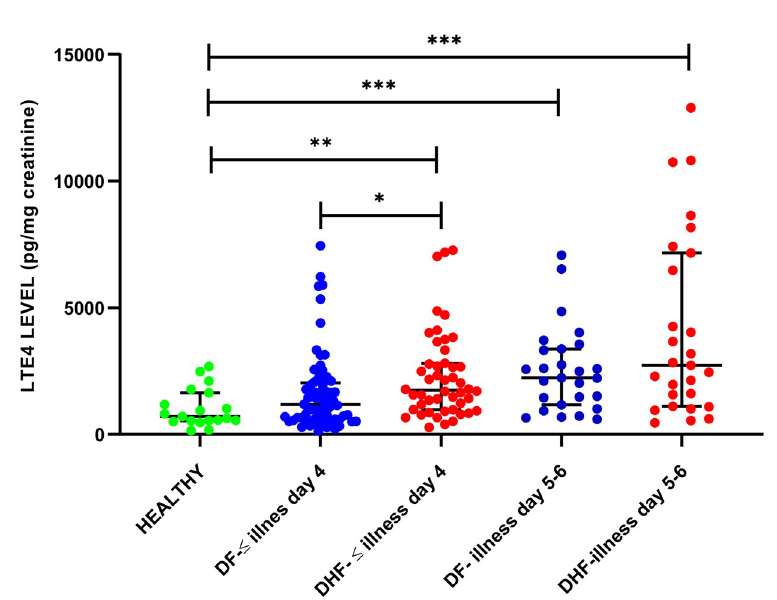
Fig 1. Urinary LTE4 levels in patients with acute dengue. Urinary LTE4 levels were measured by quantitative ELISA, in healthy individuals (n = 19), in those with DF (n = 72) and those who progressed to develop DHF (n = 48) with < 4 days of illness and in patients with DF (n = 27) and DHF (n = 27) in 5 to 7 th day of illness. The p values were calculated by the Mann-Whitney test. Error bars represent the median and IQR. � P < 0.05, �� P < 0.001, ��� P <